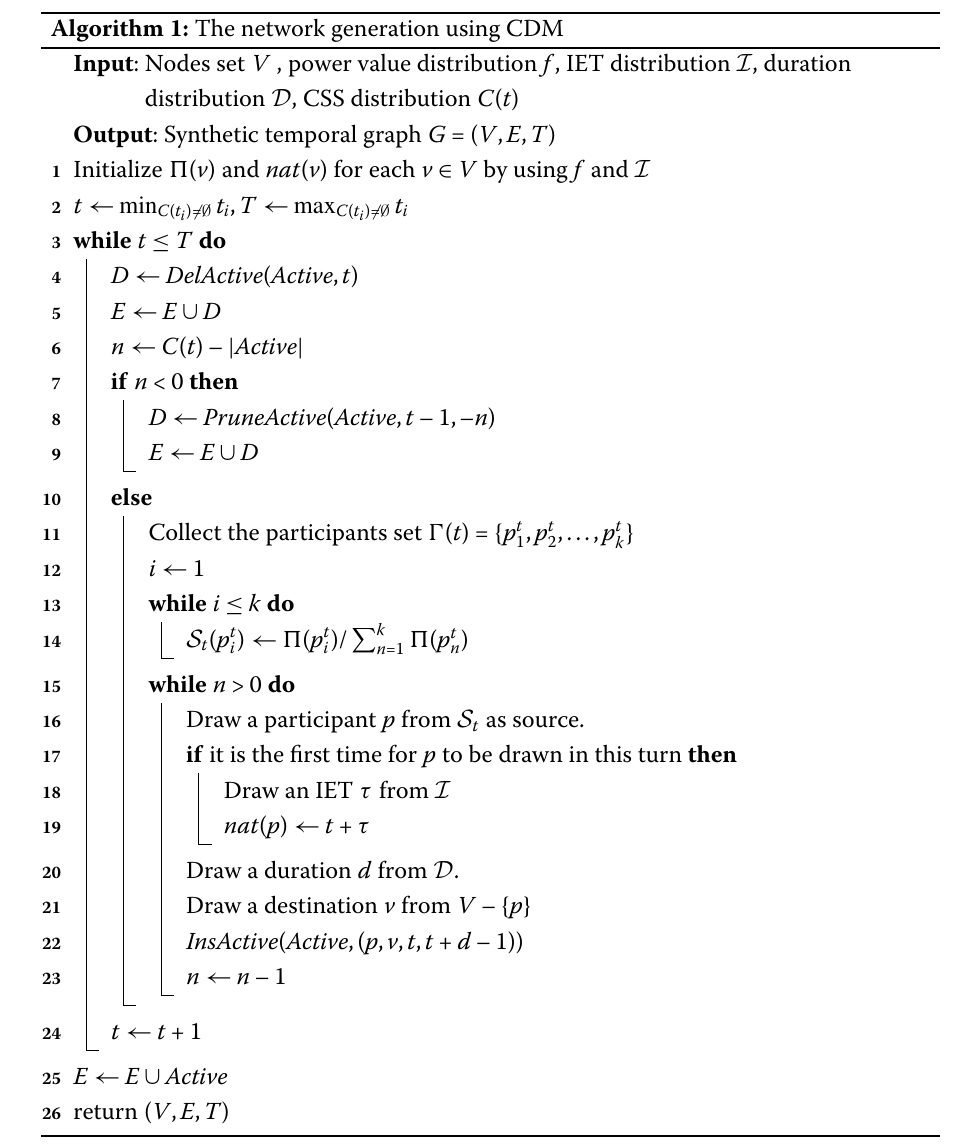
Algorithm 1: The network generation using